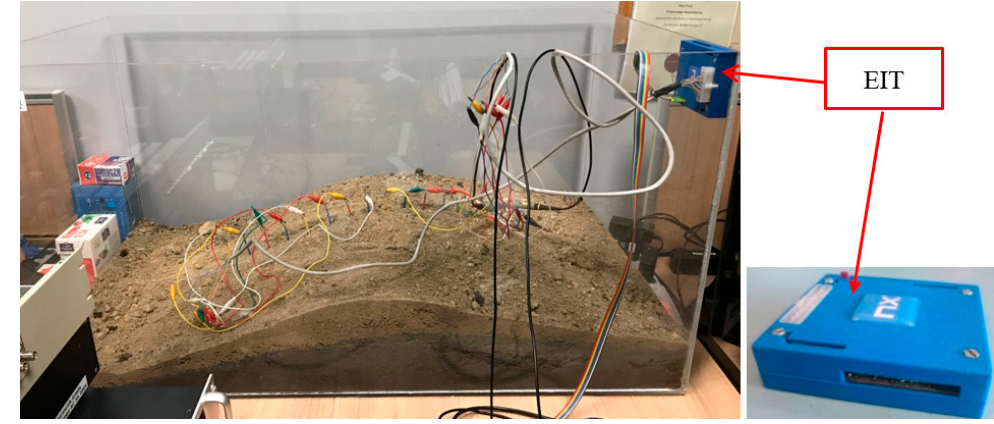
Figure 4. Flood embankment model with electrodes and EIT (Electrical Impedance Tomography) device.